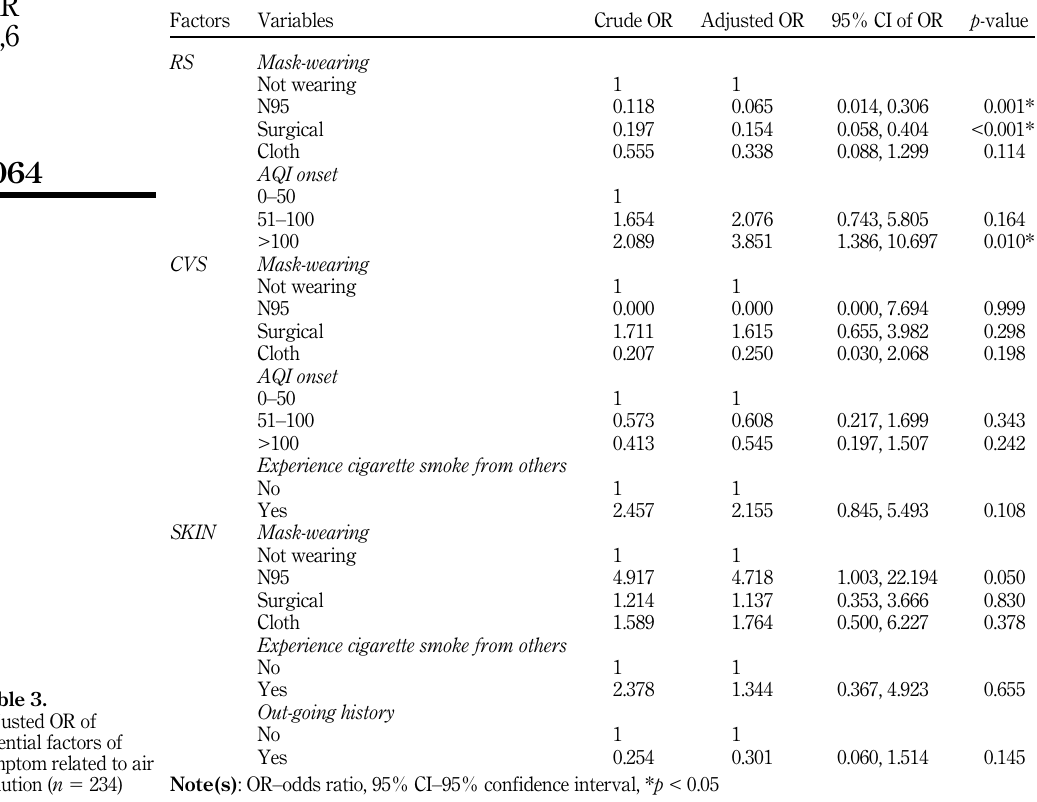
Table 3. Adjusted OR of potential factors of symptom related to air pollution ( n 5